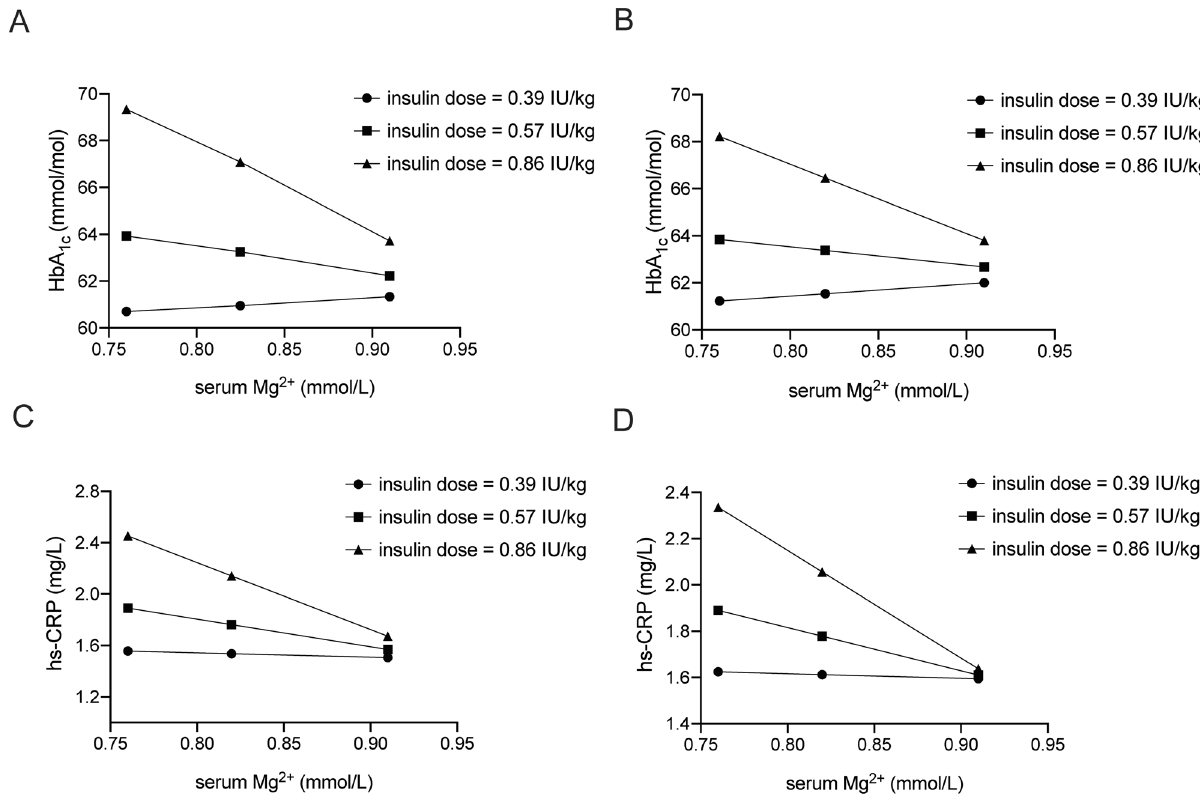
Figure 1. Plots of the association of serum Mg 2+ with HbA 1c and hs-CRP categorized by insulin dose. ( A, C ) Crude models and ( B, D ) Model 2, adjusted for: age, sex adjusted, duration of diabetes (years), eGFR (< 60, 60–90, > 60 mL/min/1.73m 2 ), alcohol use (yes/no), smoking (current, former, never), SBP (mmHg), TG (mmol/L), LDL cholesterol (mmol/L), statins (yes/no) and PPI (yes/no) drugs. eGFR = estimated glomerular filtration rate, HbA 1c = hemoglobine A1c, hs-CRP = high-sensitivity C-reactive protein, LDL = low-density lipoprotein, Mg 2+ = magnesium, PPI = proton pump inhibitor, SBP = systolic blood pressure, TG =